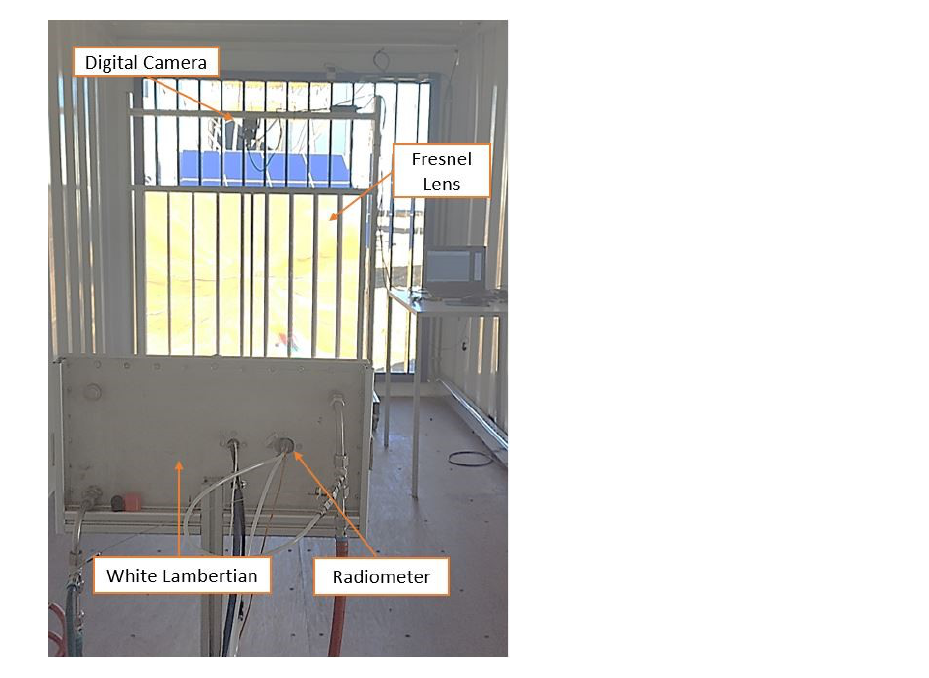
Figure 4. Measuring elements for characterizing the Fresnel lens of the new solar furnace: CMOS camera and back view of the Lambertian target with the